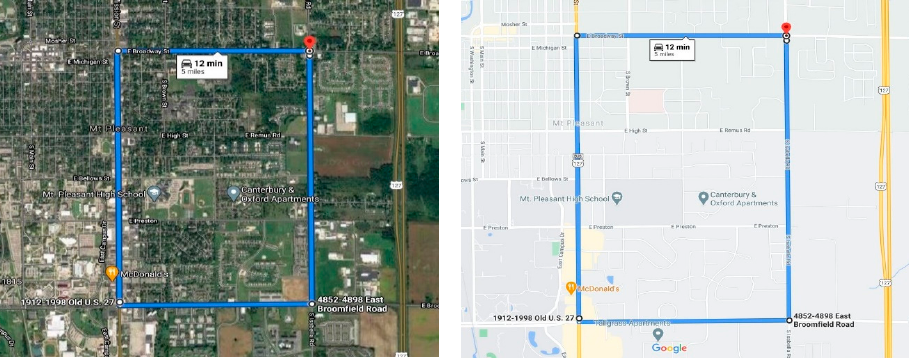
Figure 12. Route of the experimental evaluation.